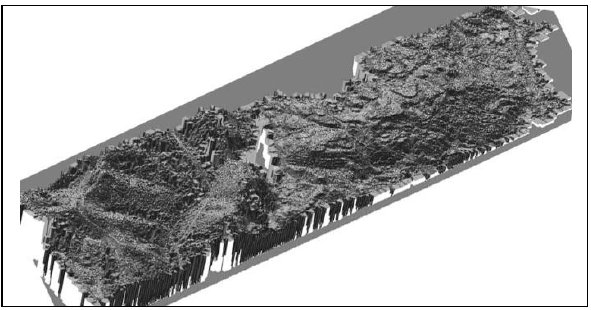
Fig. 15 : 3D shaded view to the overlapping DEM-part after filtering, three times exaggerated